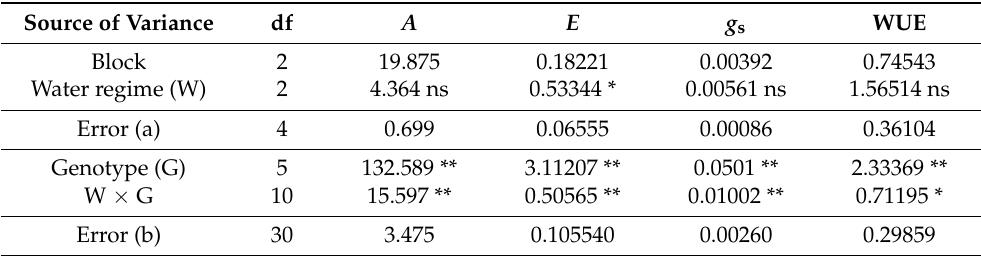
Table 7. Mean squares for net photosynthetic rate ( A ), transpiration rate ( E ), stomatal conductance ( g s ) and water use efficiency (WUE) of six sugarcane genotypes under recovery conditions (determined six months after